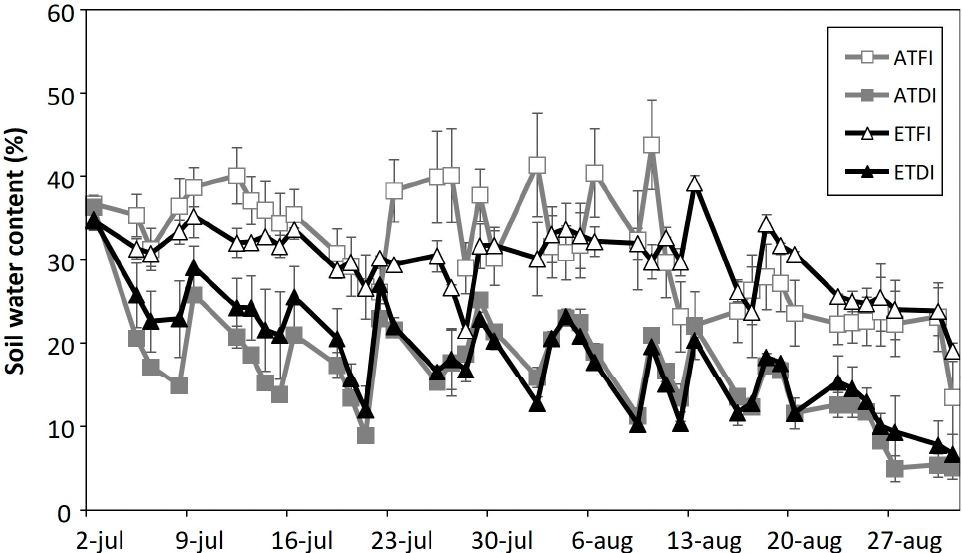
Figure 1. Soil water content measured in the pots every day from veraison to berry maturity. Each point is the mean ± S.E of 3 measurements done in the substrate of plants subjected to either at ambient (AT) or elevated temperature (ET) and subjected to different irrigation regimes (FI, full irrigation; DI, deficit irrigation).